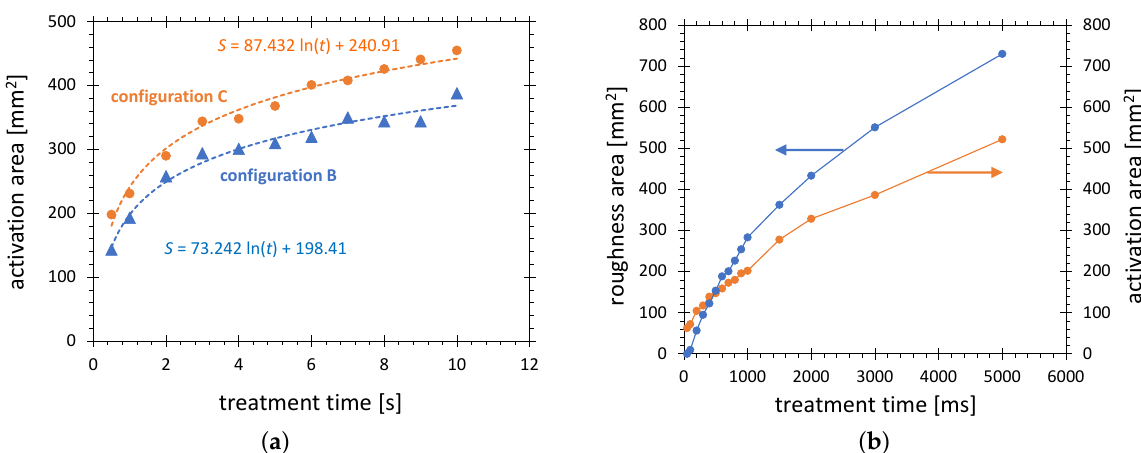
Figure 11. Dependence of activation area (58 mN/m, HDPE) on the treatment time. The plasma treatment is performed in configurations ( a ) B and C, and ( b ) A, operated at conditions from Table 1, respectively. The area of thermally induced loss of glossiness is included for